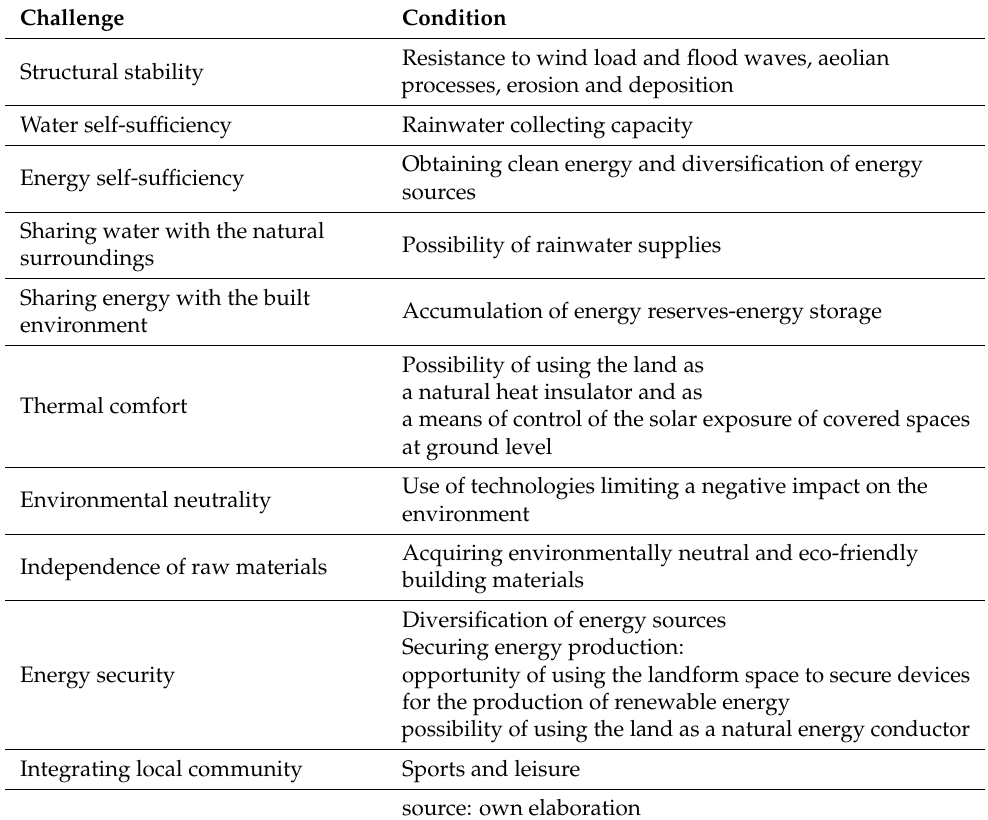
Table 1. Challenges in the design of architecture in the Anthropocene and conditions that should be